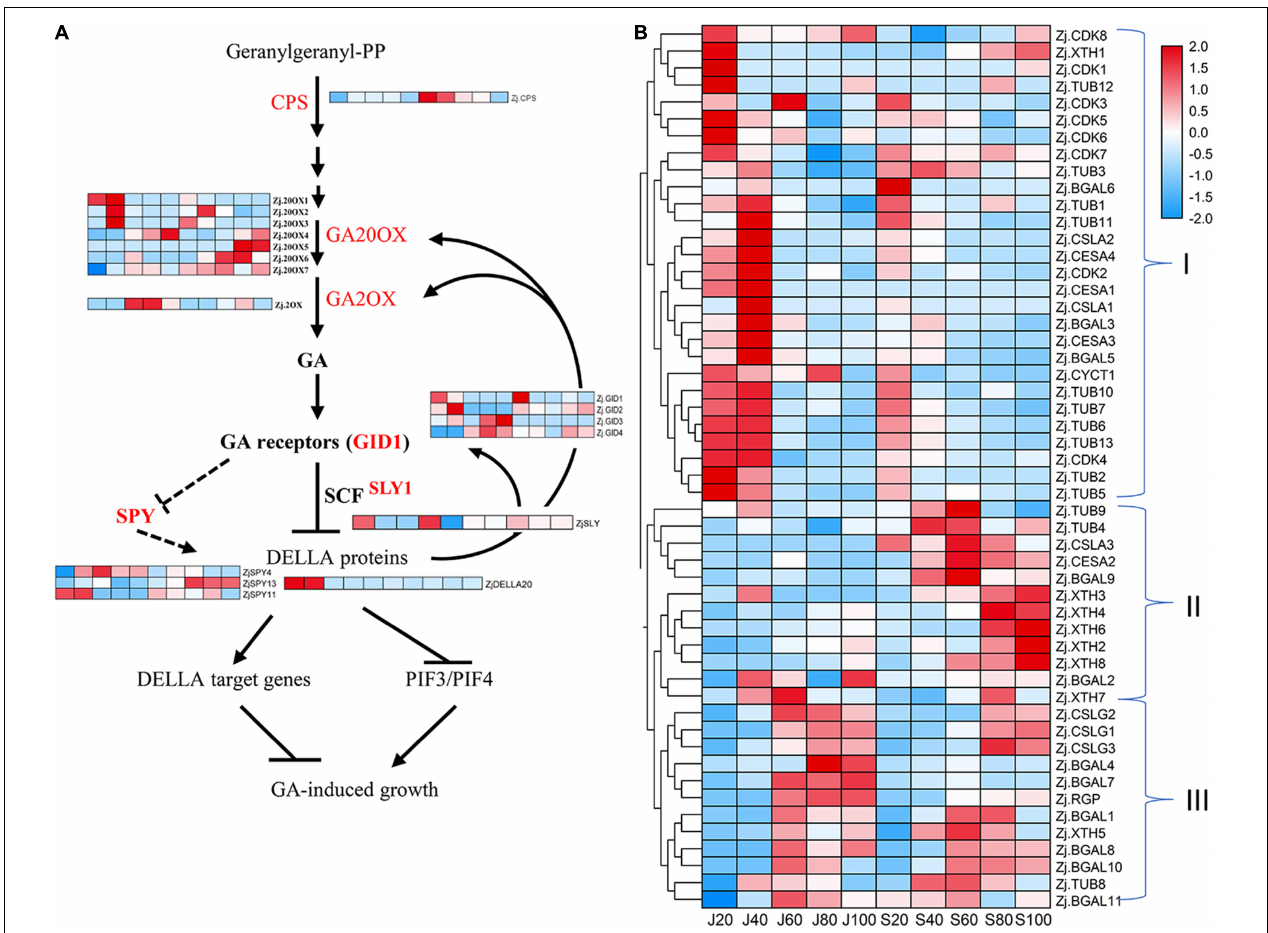
FIGURE 5 | Accumulation profile of proteins associated with gibberellin (GA) and cell division and expansion. (A) Expression of identified proteins involved in GA biosynthesis and signal transduction. (B) Expression pattern of proteins related to cell production and cell wall